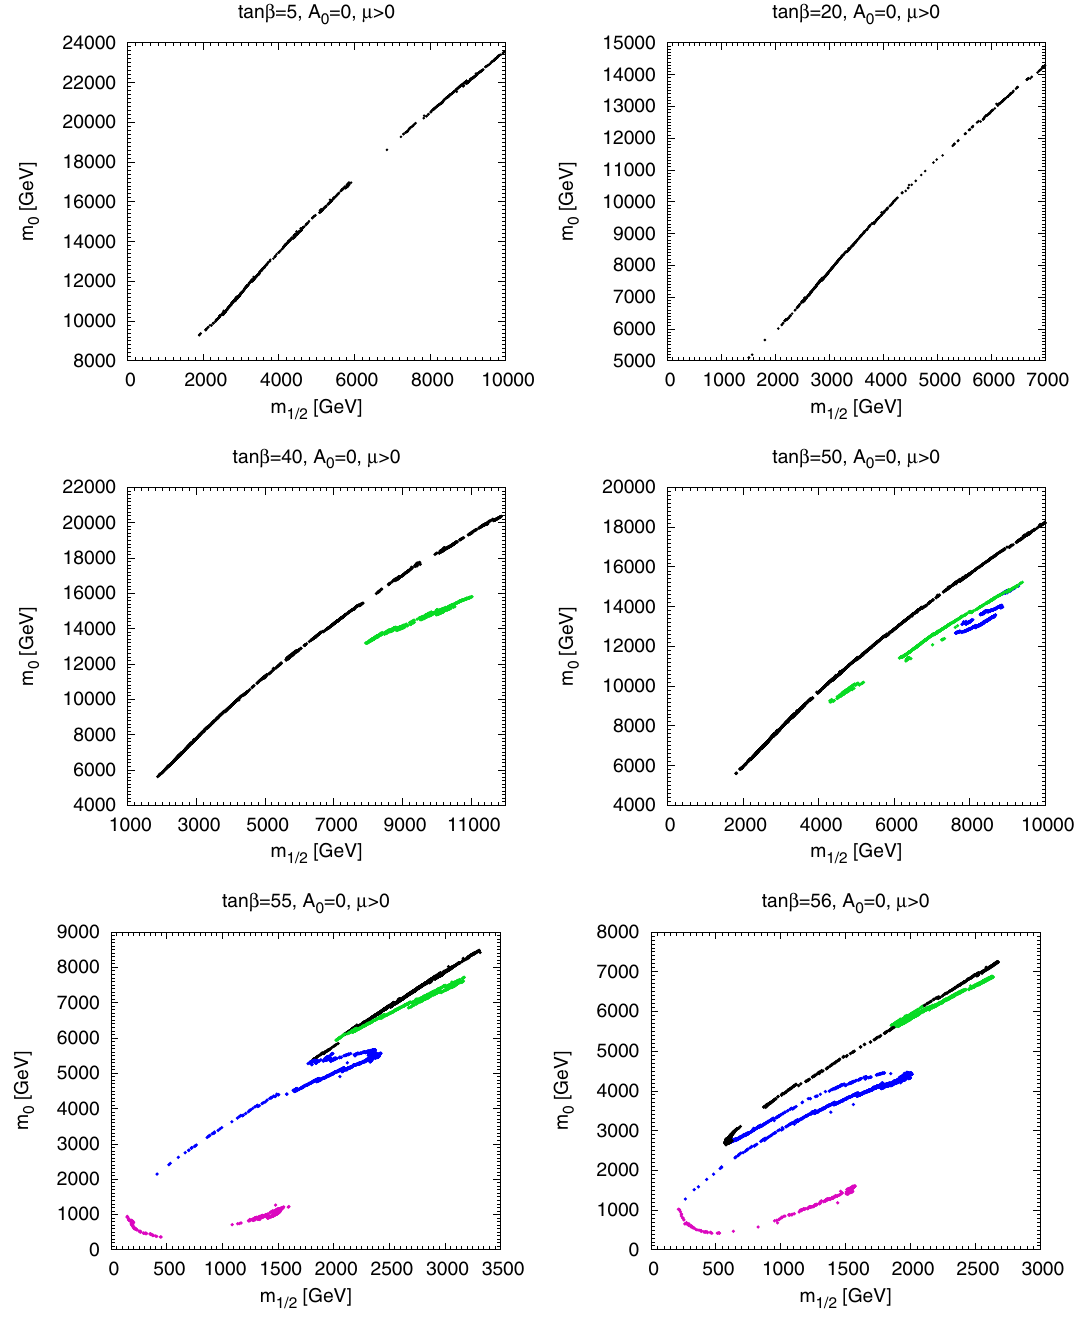
Fig. 1 The dark matter strips for tan β = 5 , 20 , 40 , 50 , 55 and 56, all assuming A 0 = 0 and μ > 0